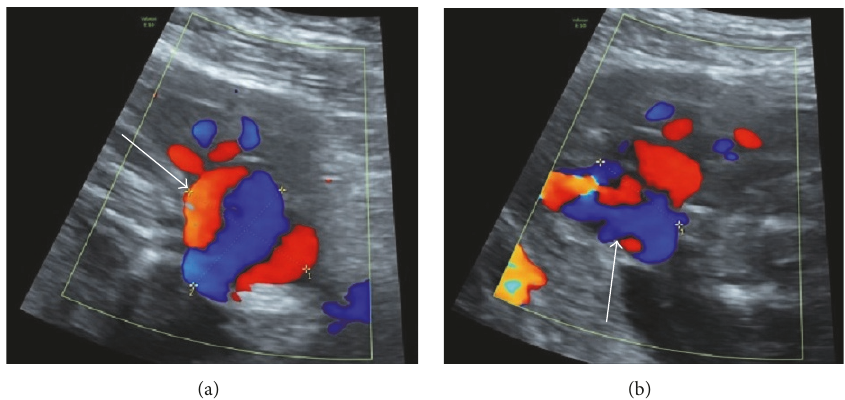
Figure 8: Transverse (a) and longitudinal (b) ultrasound two days after procedure reveal return of flow to the lesion, however, with significant reduction in lesion size to 3.3 cm (arrows) form 5cm before embolization.